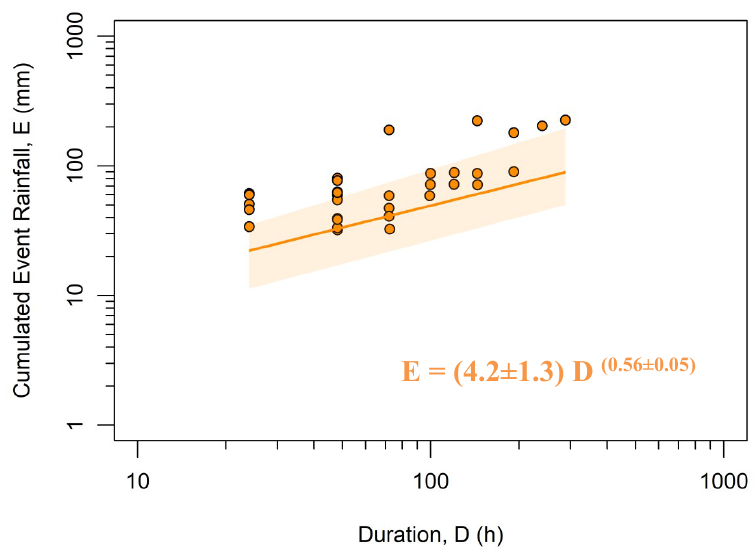
Figure 4. Cumulated event rainfall-rainfall duration (ED) thresholds for Kalimpong Region at a 5% exceedance probability level (T 5,B ). The shaded area depicts the uncertainty associated with the threshold.